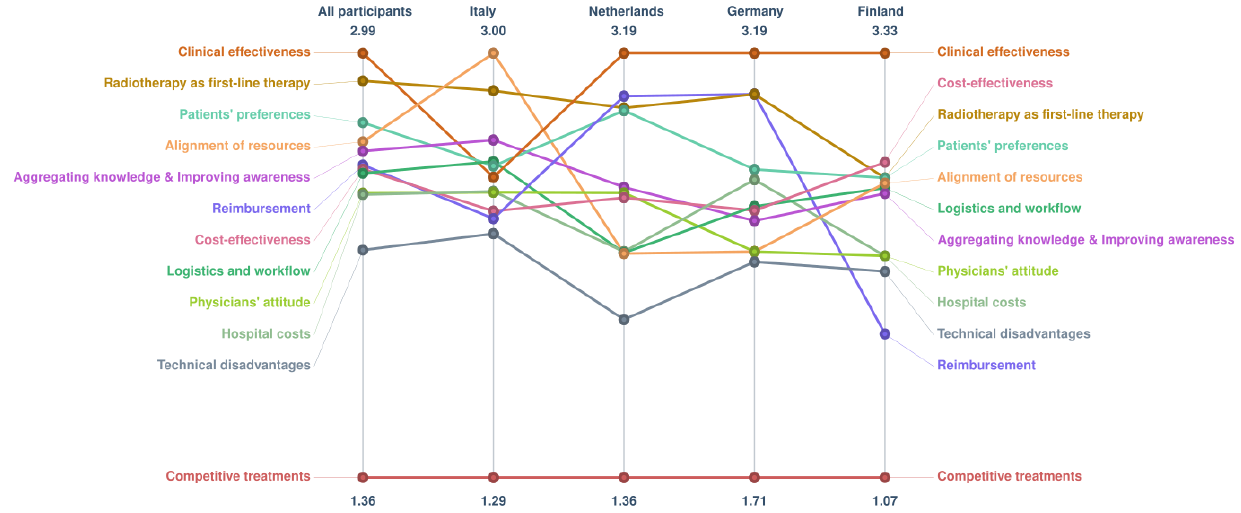
Figure 4. Importance of clusters per country subgroup. Pattern matches show the average rating value (calculated from Likert scales ranging from 0 to 4).